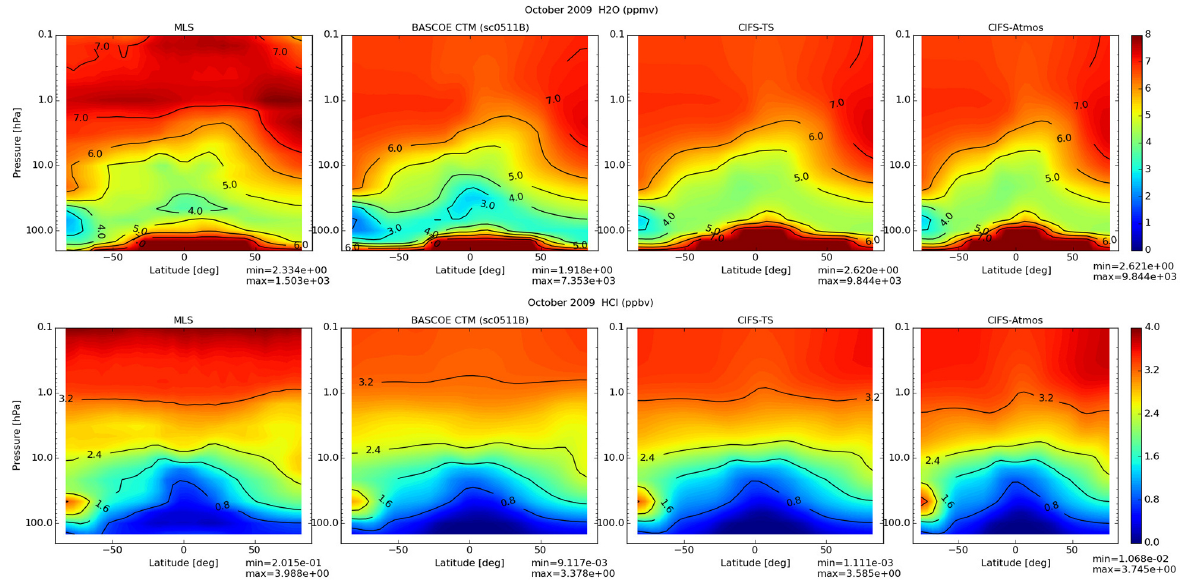
Figure 10. Zonal mean stratospheric H 2 O (top, units ppmv) and HCl (bottom, units ppbv) for October 2009 using Aura/MLS observa- tions (first column) and co-located output of BASCOE-CTM (second), C-IFS-TS (third) and C-IFS-Atmos